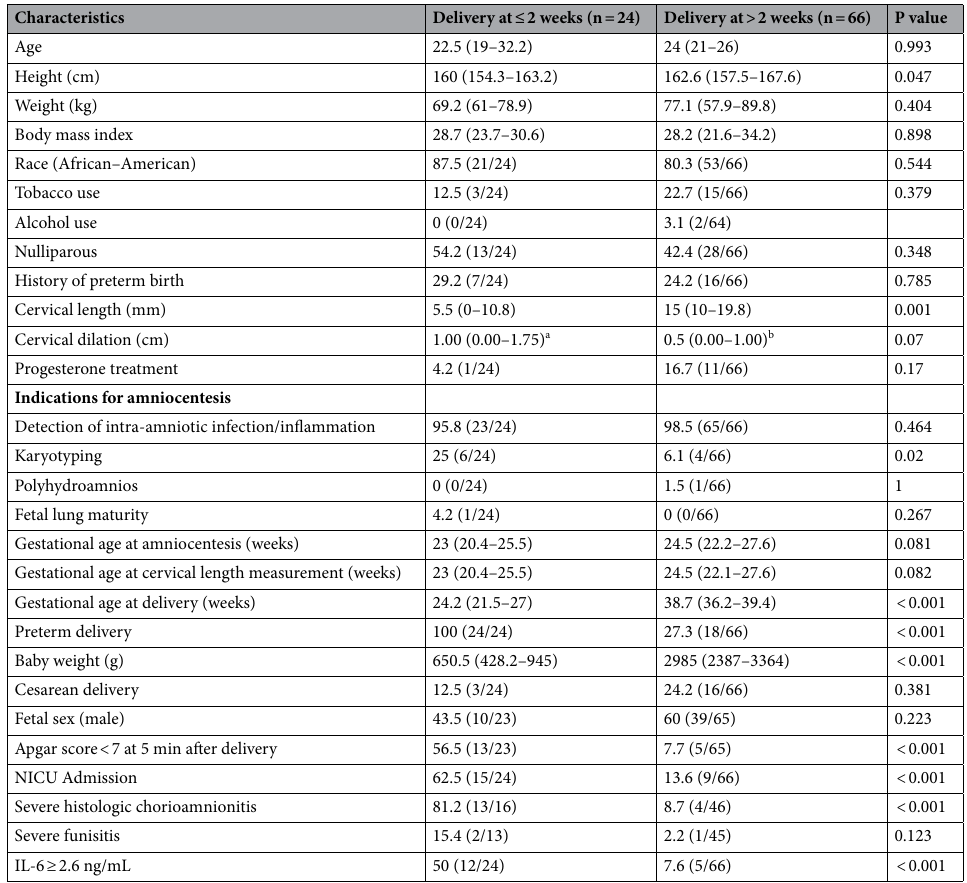
Table 1. Demographic and clinical characteristics of the study population. Data are presented as median (IQR) for continuous and % (n/N) for categorical variables. P-values calculated by Wilcoxon-signed rank tests and Fisher’s exact tests. Note, data were missing for select variables presented in the Table. NICU: neonatal intensive care unit. a Missing one datum. b Missing 7 data